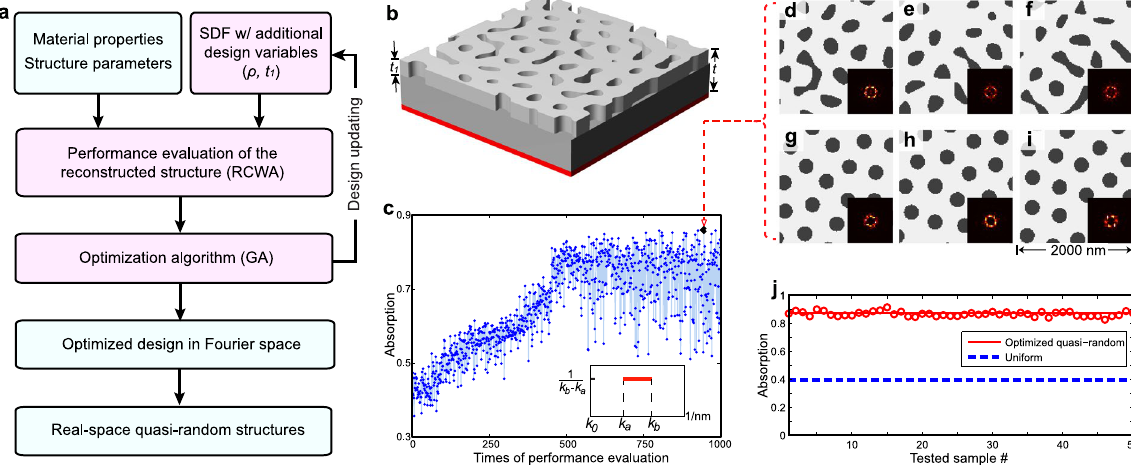
Figure 3. Fourier space design strategy of non-deterministic quasi-random nanophotonic structures. ( a ) The simulation-based design approach for optimizing quasi-random nanophotonic structures in Fourier space based on the structural characterization using SDF. ( b ) The schematic view of the simplified thin-film silicon solar cell model with quasi-random light-trapping structure. The cell is characterized by the thickness of the silicon layer t, and the thickness of scattering layer t 1 . ( c ) Optimization history for designing the quasi-random light-trapping structure in the absorber (t = 600 nm, t 1 = 100 nm) at λ = 650 nm using genetic algorithm. ( d – i ) Six different real-space quasi-random structures reconstructed from the optimal solution, where d-f with the channel-type morphology are reconstructed using Gaussian random field modeling and ( g – i ) with the disk- type morphology are reconstructed using random packing algorithm. ( j ) The absorption performance of 50 randomly generated quasi-random light-trapping structures from the optimal